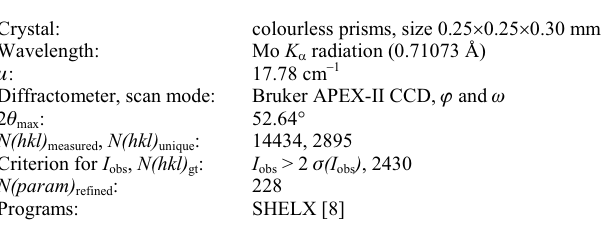
Table 1. Data collection and handling.